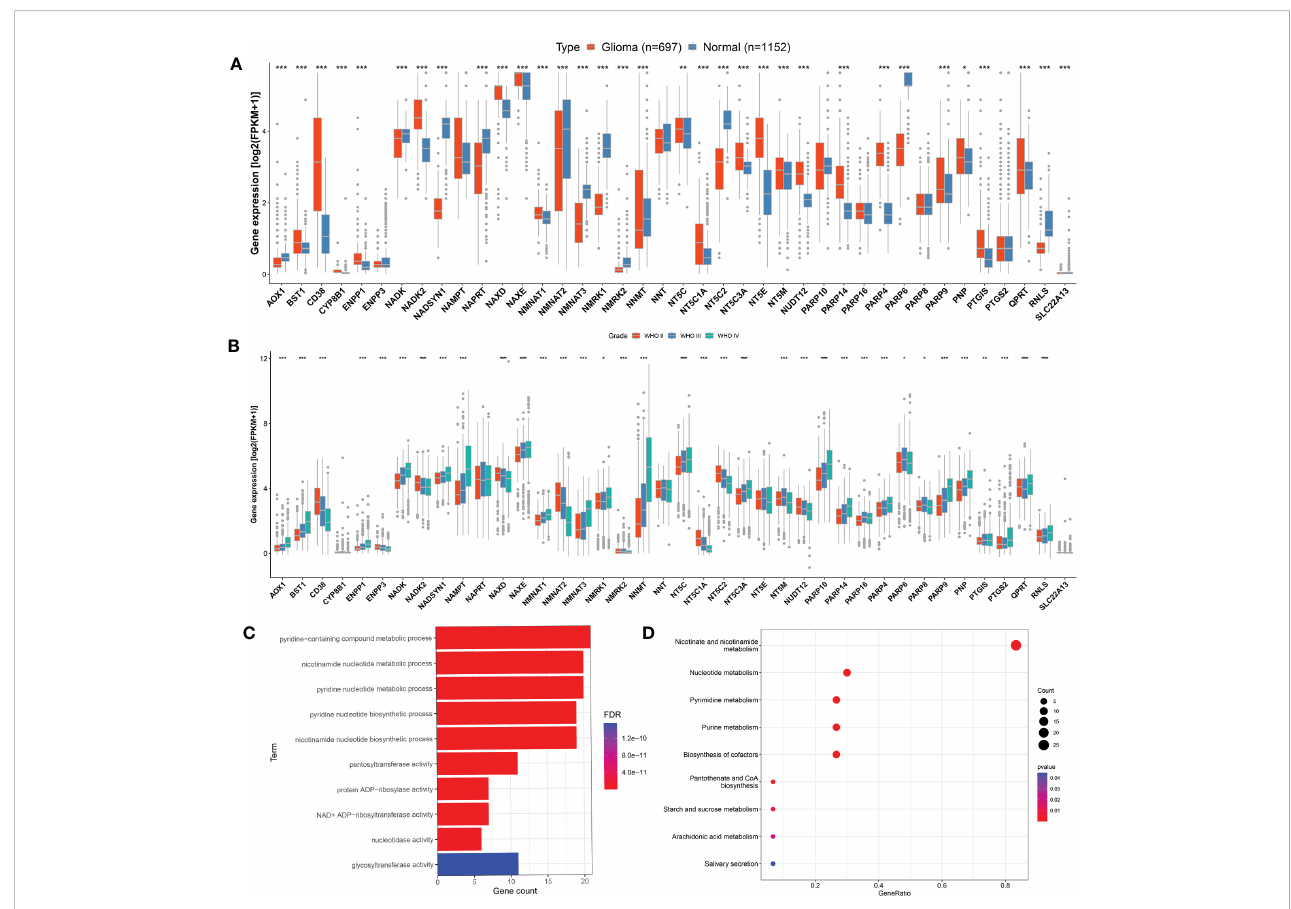
FIGURE 2 Evaluation of NMRGs in glioma. (A) Comparison of the expression levels of the NMRGs in normal brain tissue (GTEx) and glioma (TCGA). (B) Comparison of the NMRGs expression in different grades of glioma analyzed in CGGA glioma samples. (C, D) GO and KEGG pathway analysis of the